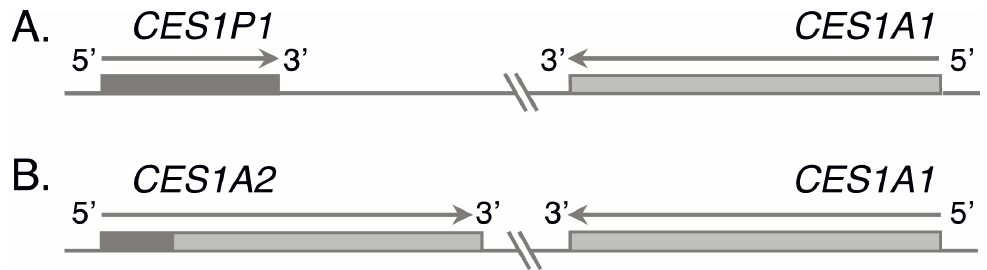
Figure 1. Main structural haplotypes of CES1 containing CES1P1 ( A ) or CES1A2 ( B ). Light gray and dark gray show regions corresponding to the CES1A1 and CES1P1 sequence, respectively.